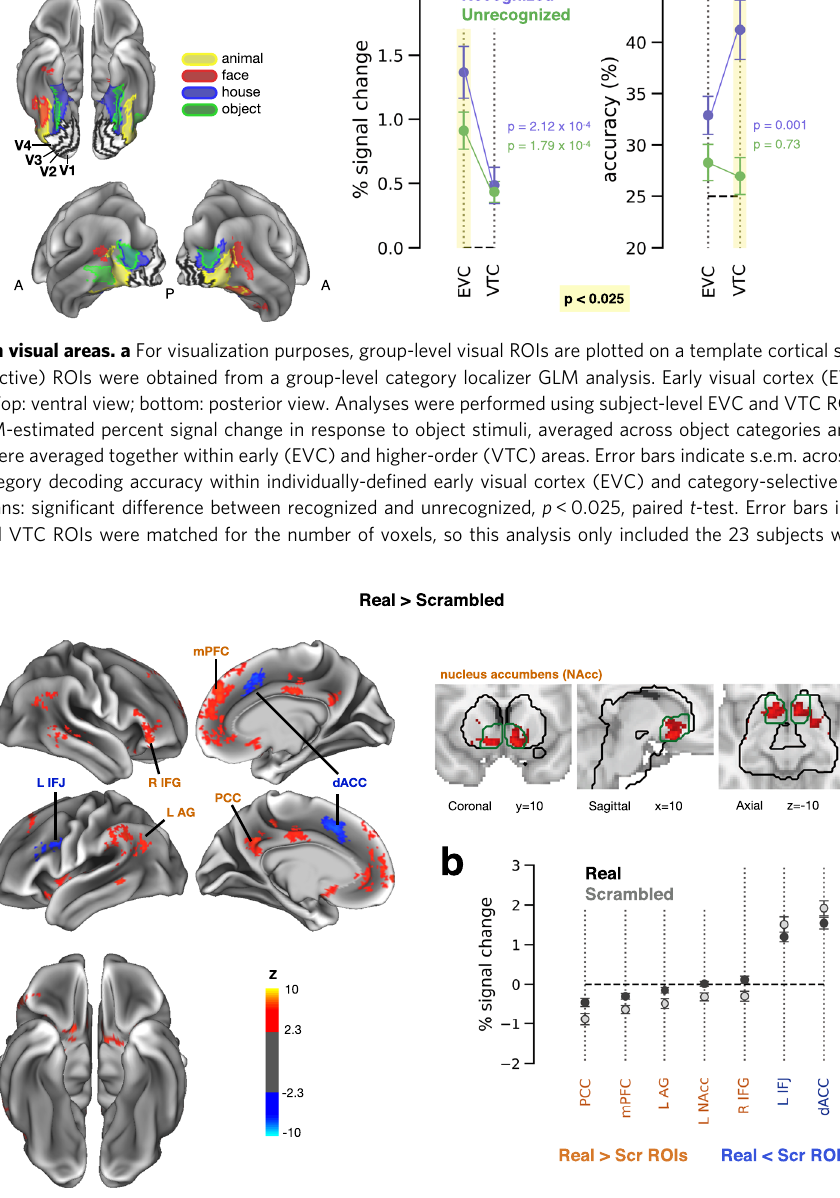
Fig. 3a, left: V1: t 22 = 3.97, p = 6.47 × 10 − 4 ; V2: t 22 = 2.62,